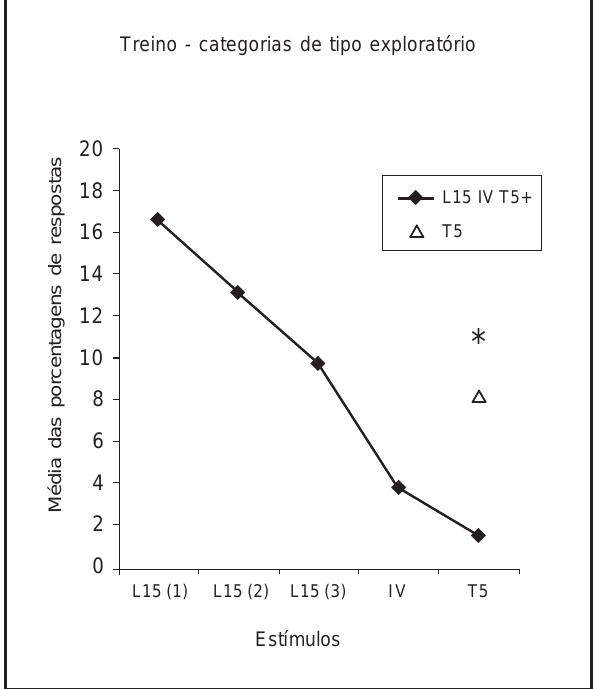
Figura 2. Médias das porcentagens de resposta das categorias de orientação ao bebedouro agrupadas ( head-jerk +lamber e\ou farejar o bebedouro) nas práticas L5 IV R15- e R15+ durante as cinco últimas sessões da fase de aquisição. L= luz; R= Ruído; IV= intervalo vazio. R15(1), R15(2), R15(3) correspondem a blocos de 5 segundos de R15.